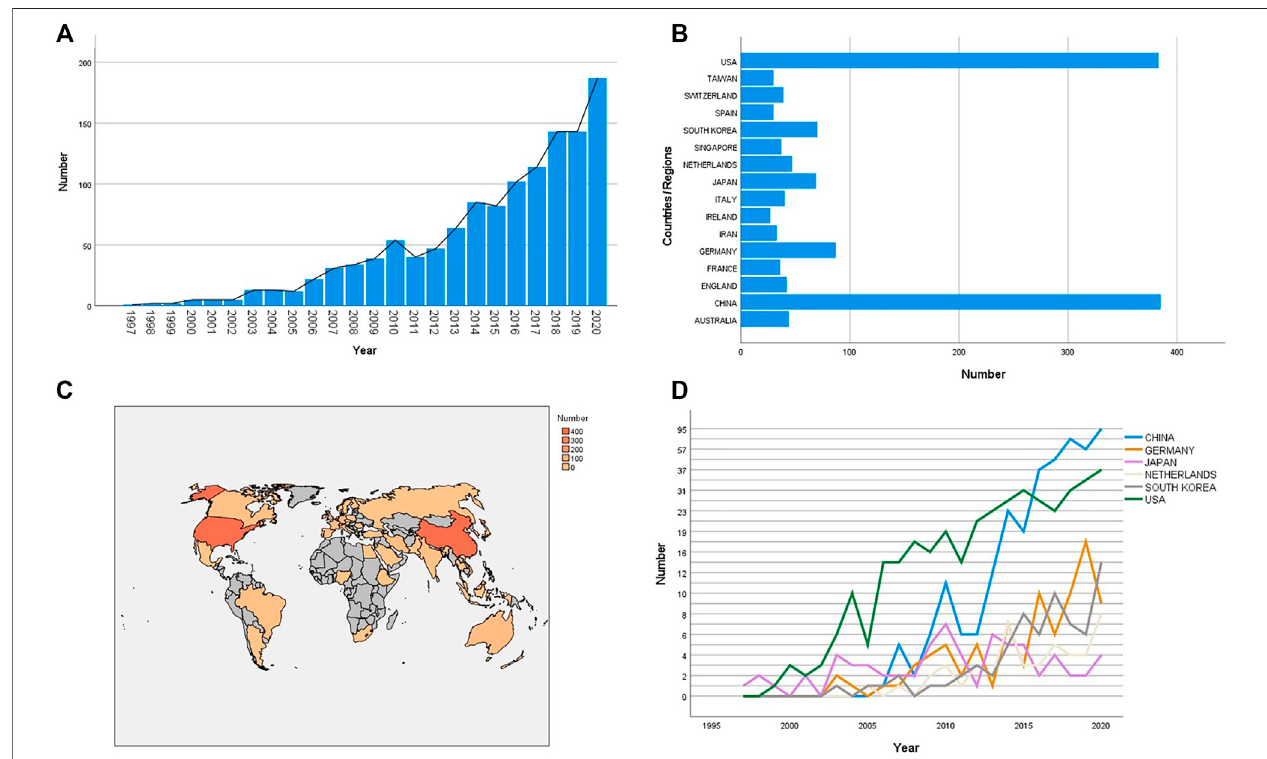
Figure2| GlobaltrendsandcountriescontributingtoresearchofhydrogelinCartilagerepair (A) TheAnnualnumberofpublicationsrelatedtoresearchofhydrogel in cartilage repair. (B) The sum of publications about research of hydrogel in cartilage repair from the top 16 countries. (C) The Worldwide heat map showing the contribution of different countries to research of hydrogel in cartilage repair.The area with the darker color contributes more to researches. (D) The Number of publications from top 6 countries over time.